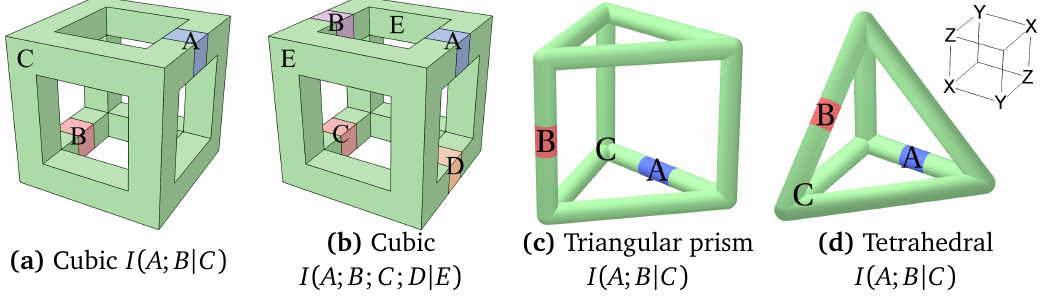
Figure 3: (a) Cubic I ( A ; B | C ) , (b) cubic I ( A ; B ; C ; D | E ) , (c) triangular prism I ( A ; B | C ) , and (d) tetrahedral I ( A ; B | C ) entanglement schemes for foliated fracton phases. (d) Stabilizer for the Chamon model defined on a cubic lattice with one qubit per vertex